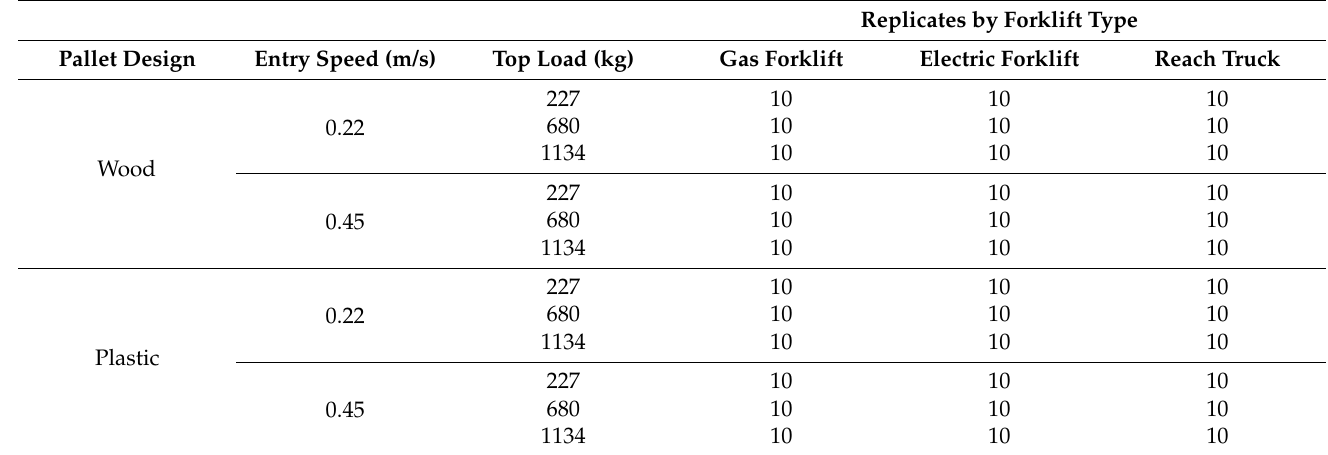
Table 3. Specifications for experimental